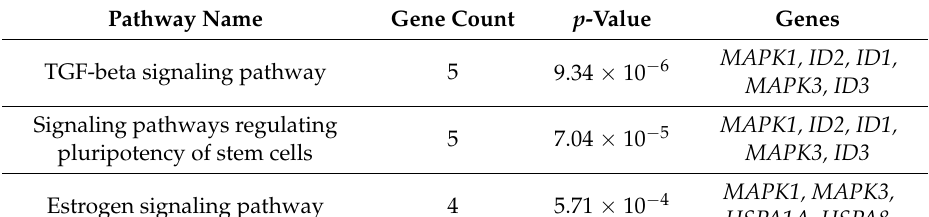
Table 2. The top three pathways with the 14 common overlapping genes with EEDs, ID proteins, and depression.